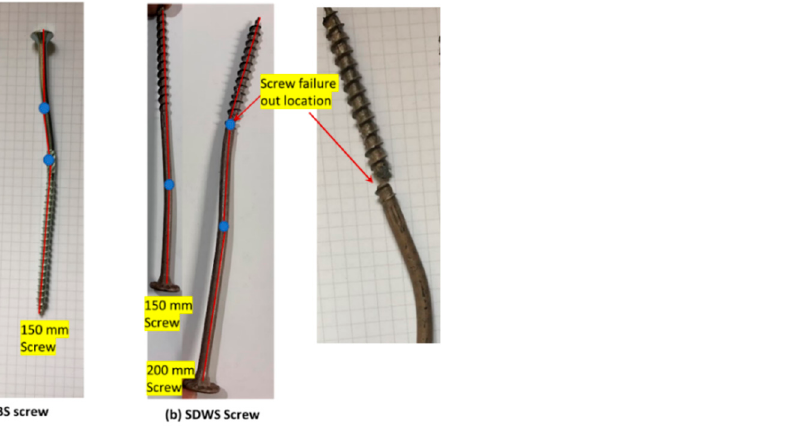
Figure 22. Failure mode: plastic hinge formation of the screws in Connection-B: ( a ) HBS screw; ( b ) SDWS screw.